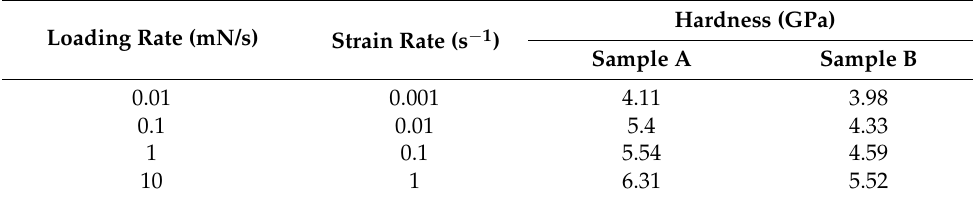
Figure 7. Typical load–depth curve with various strain rates at the same Pmax = 10 mN. ( a ) Linear scanning strategy (sample A), ( b ) linear and 90° rotation scanning strategy (sample A). Table 2. Various loading rates, strain rates, and corresponding nanohardnesses for PBF-EB AM Ti6Al4V alloys with different scanning strategies.